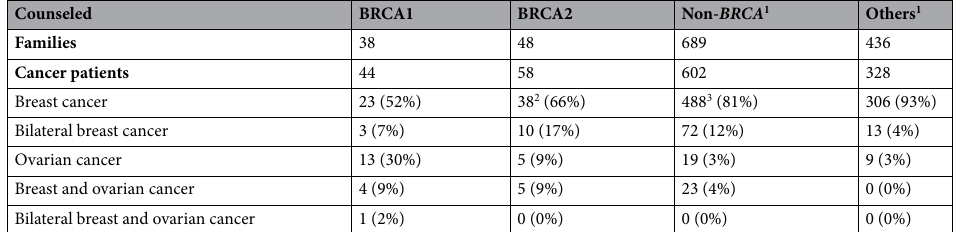
Table 3. Total number of cancer patients and families who were counseled in 1996–2020. 1 Non- BRCA and others group includes healthy relatives of a cancer patient, who is not from southwestern Finland and hence not included cancer patients. 2 Includes 4 male breast cancer patients. 3 Includes 28 male breast cancer patients.